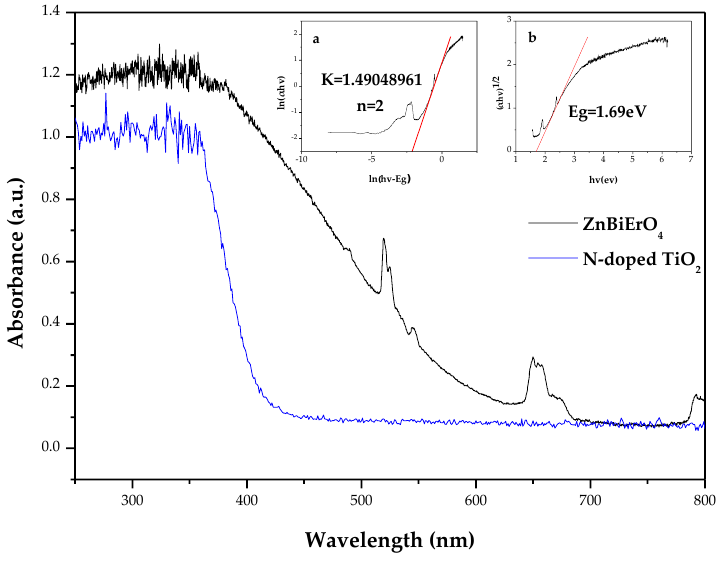
Figure 9. UV-Vis absorption spectra of ZnBiErO 4 and N-doped TiO 2 . ( a ) plot of ln( α h ν ) versus ln( h ν − E g ) for ZnBiErO 4 . ( b ) plot of ( α h ν ) 1/2 versus h ν for ZnBiErO 4 .